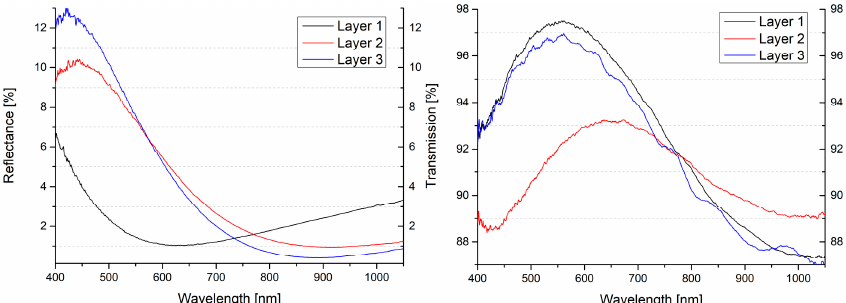
Figure 11. Transmittance and reflectance spectra ( a ) as well as refractive index ( b ) of calcined CaF 2 thin films and for a glass substrate as function of the wavelength. Reproduced from Reference [47] with the permission of the Royal Chemical Society.